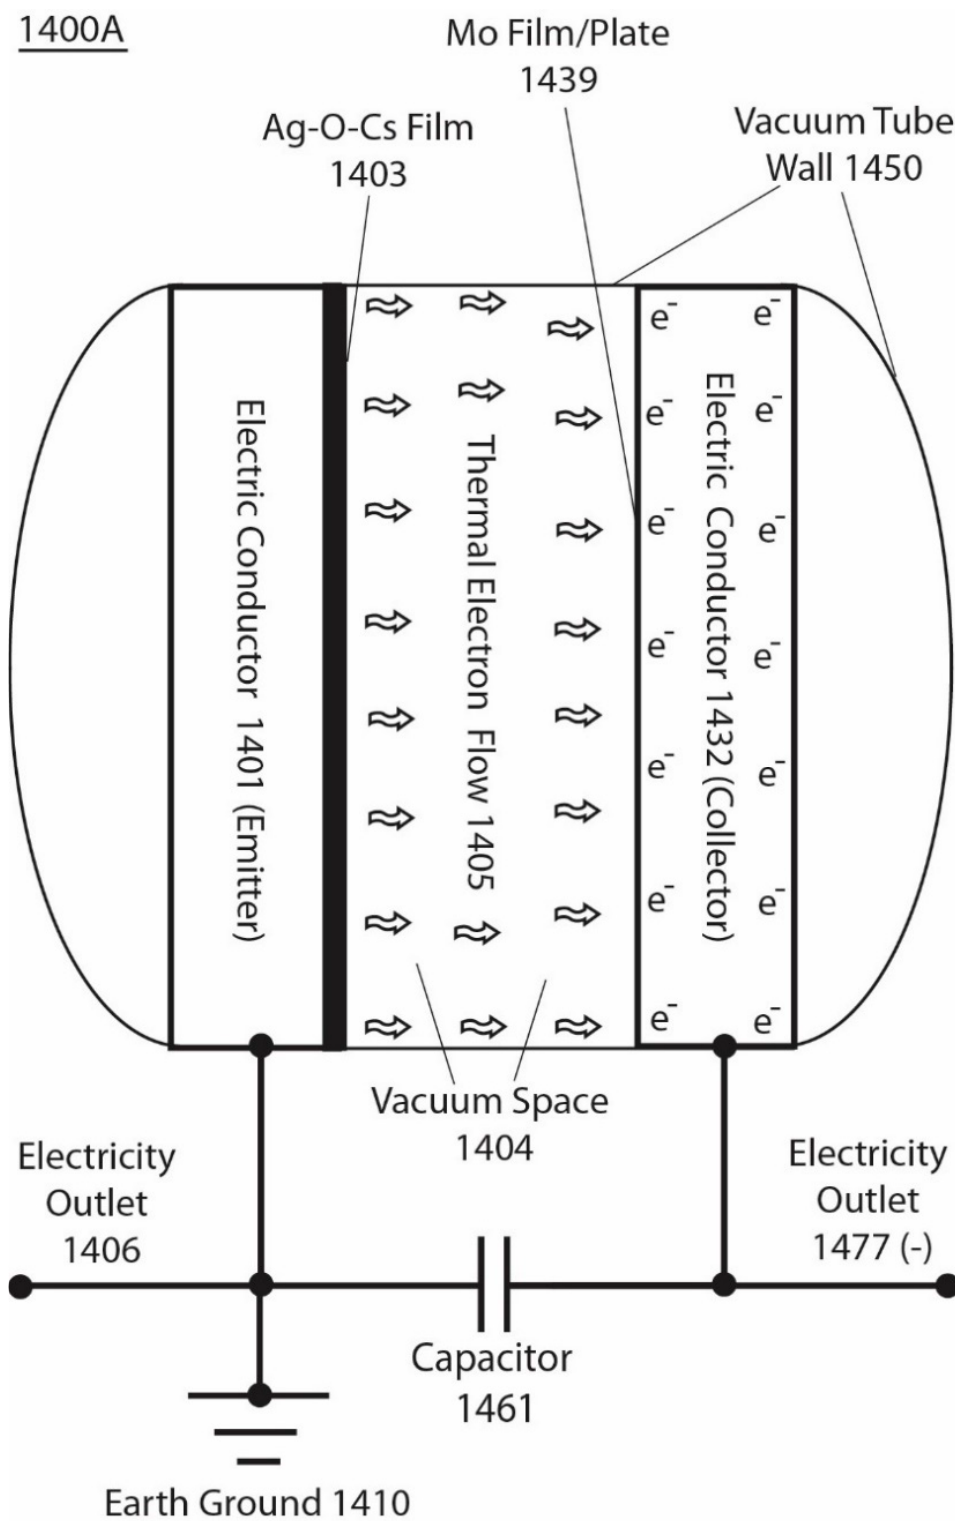
Figure 4. Presents an example of a prototype for an isothermal electricity production system 1400A that has an emitter (electron-work function 0.7 eV) and a collector (electron-work function 4.36 eV) installed in a container such as a vacuum tube